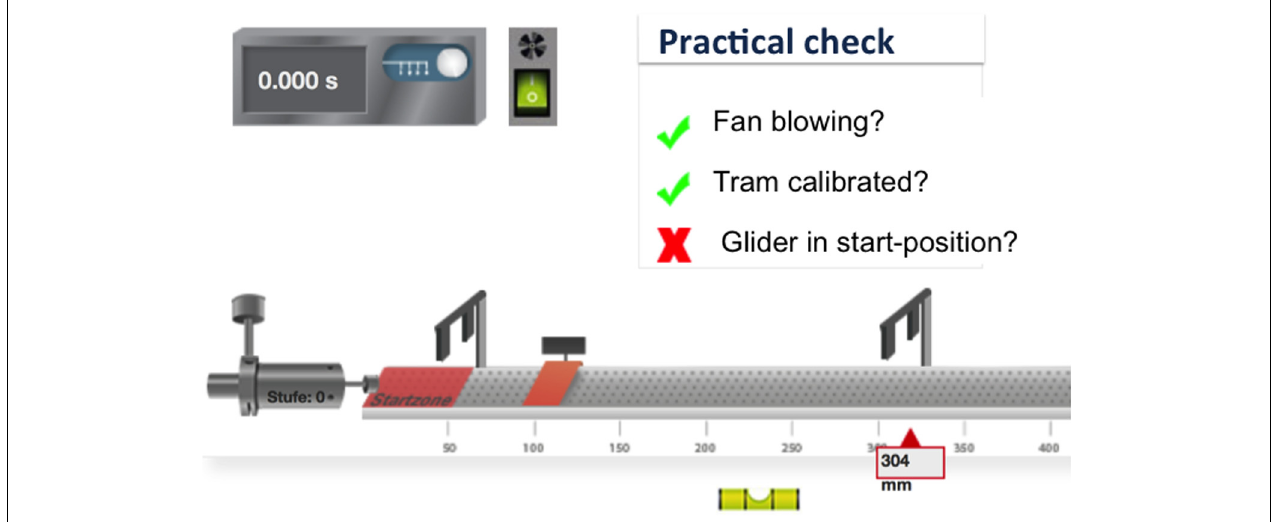
FIGURE 2 | Experiment chapter within the virtual learning environment: air cushion tram (Roth et al., 2014, p. 5).